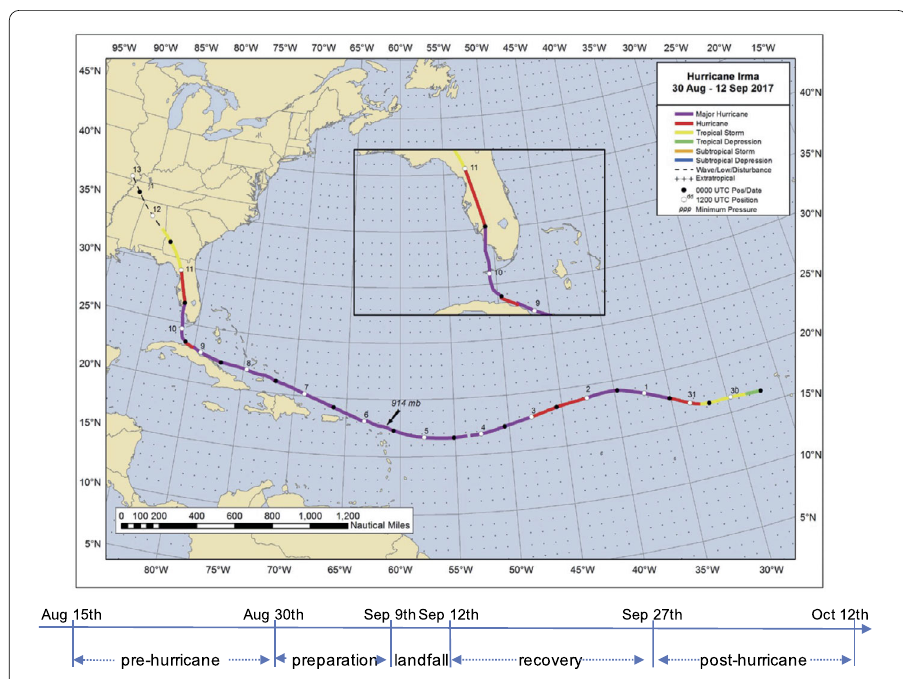
Figure 1 Track positions of Hurricane Irma by the US National Oceanic and Atmospheric Administration